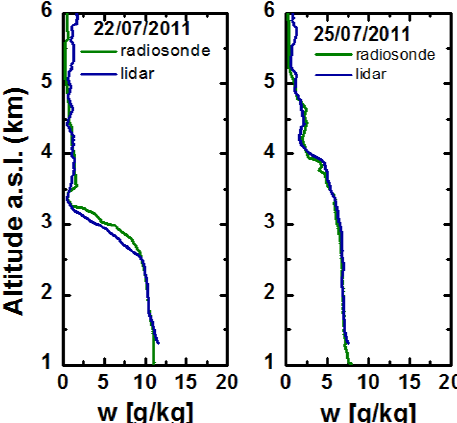
Fig. 2. Water vapour mixing ratio profiles from radiosonde and Ra- man lidar during night-time on (left) 22 July and (right) 25 July,